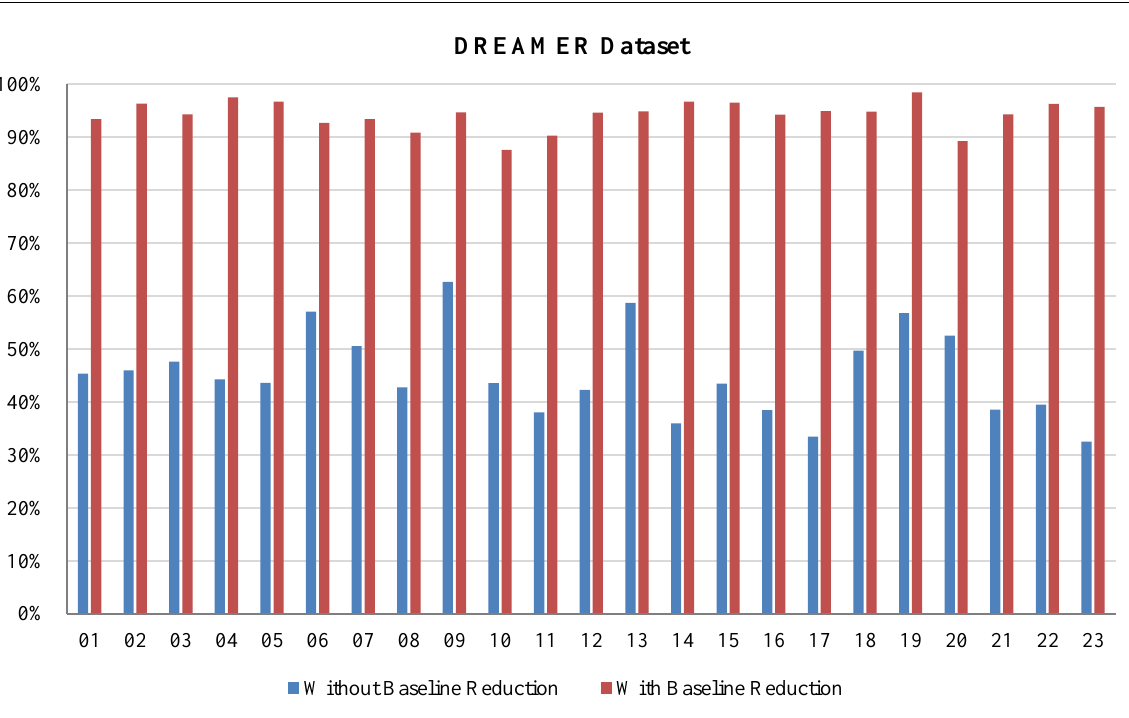
Figure 10. Comparison accuracy with and without baseline reduction approach on the DREAMER